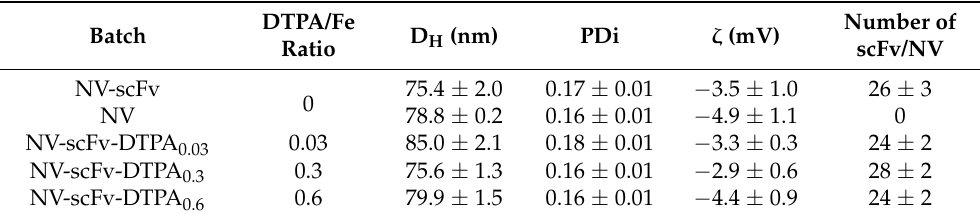
Table 2. Physico-chemical properties and number of anti-EGFR scFv ligands on different batches of NV-scFv-DTPA.